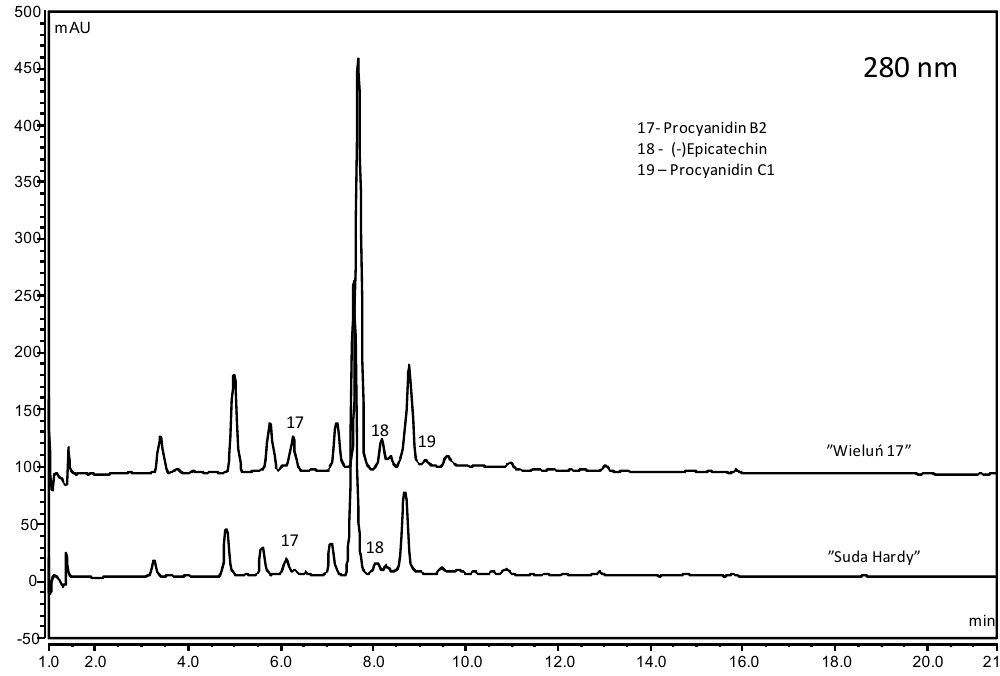
Figure 4. Chromatograms (280 nm) of sour cherry fruit cultivars with the highest and the lowest content of phenolic acids. Table 4. Antioxidant capacity (mg GAE / 100 g FW, µ mol TE / 100 g FW) of sour cherry fruit of 21 cultivars.